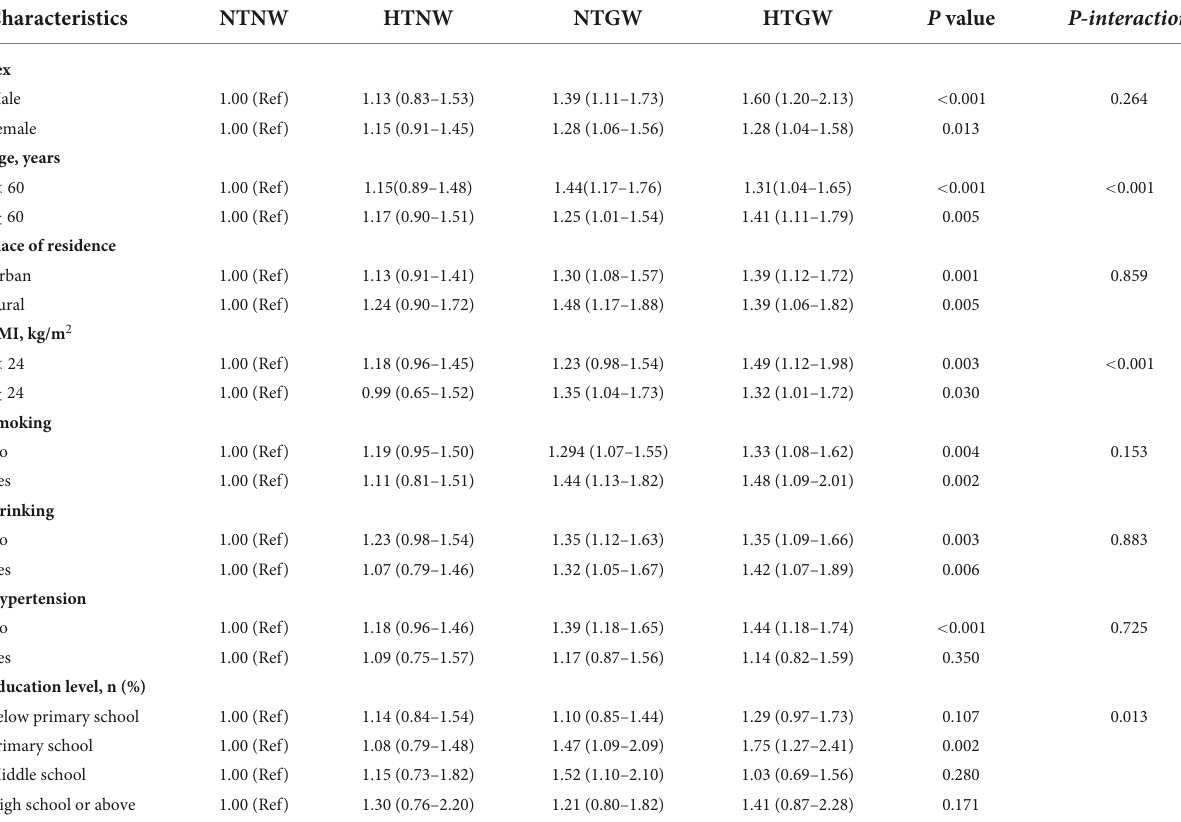
TABLE 3 Subgroup analysis of the association between high triglyceride levels and enlarged waist circumference (HTGW) phenotype and risk of cardiovascular disease (CVD).